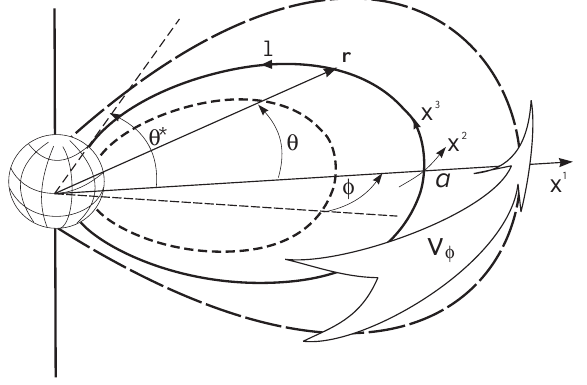
Fig. 1. A magnetospheric model with dipole magnetic field and az- imuthally rotating plasma ( v = ( 0 ,v φ , 0 ) ). Coordinate systems tied to magnetic field lines are shown: a curvilinear orthogonal system ( x 1 ,x 2 ,x 3 ) and a non-orthogonal system of coordinates ( a,φ,θ ), used in numerical